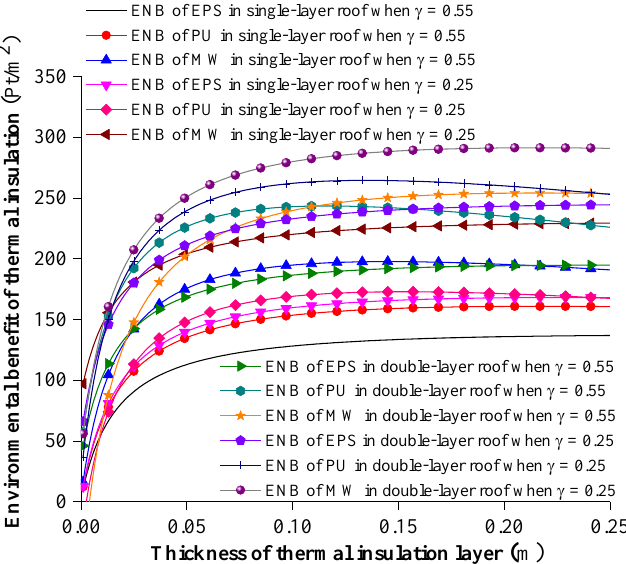
Figure 8. Environmental benefit of roof thermal insulation. The maximum environmental benefit value of EPS, PU, and MW is 136.53, 159.55, and 196.66 Pt/m 2 for the single-skin roof with a 0.55 solar radiation reflectivity coefficient, respectively. The maximum environmental benefit value of EPS, PU, and MW is 166.69, 172.80, and 229.67 Pt/m 2 for the single-skin roof with a 0.25 solar radiation reflectivity coefficient, respectively. The maximum environmental benefit of EPS, PU, and MW in- creases with decreasing solar radiation reflectivity coefficient of the outer surface of the roof. This implies that the environmental need to install a thermal insulation layer in the roof increases with decreasing solar radiation reflectivity coefficient of the outer surface of the roof.